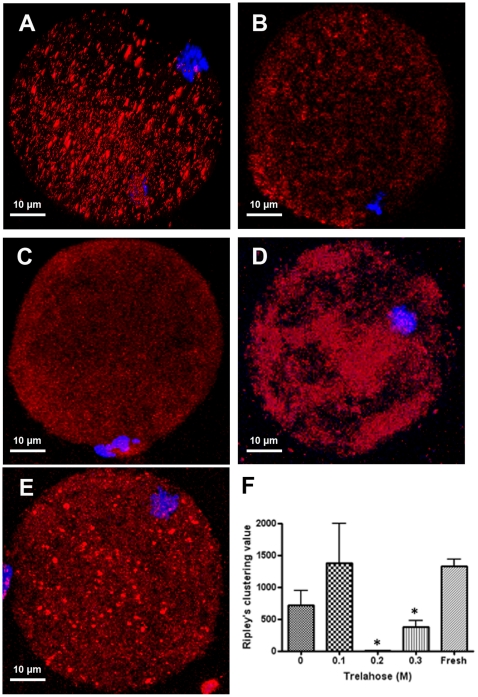
Assessment of mitochondrial integrity in fresh (A) or vitrified mouse oocytes in the presence of 0 (B), 0.1 (C), 0.2 (D) or 0.3 (E) trehalose labelled with Deep MitoTracker Red.Nuclei were stained with DAPI. The level of clustering of mitochondria (F) at the distance criterion (r) of 5 µm, displayed as mean ± SEM. Treatment groups that were significantly different (p<0.05) to that of Fresh oocytes are denoted by *.